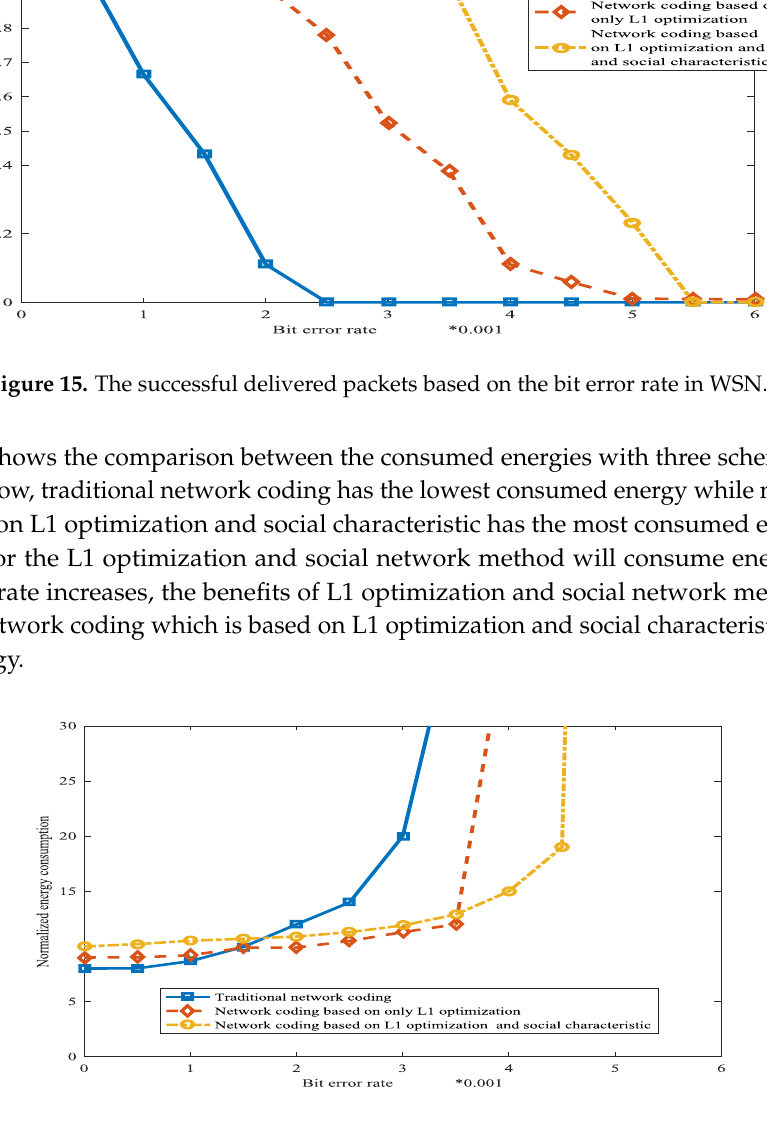
Figure 16. The normalized consumed energy based on the bit error rate in WSN.